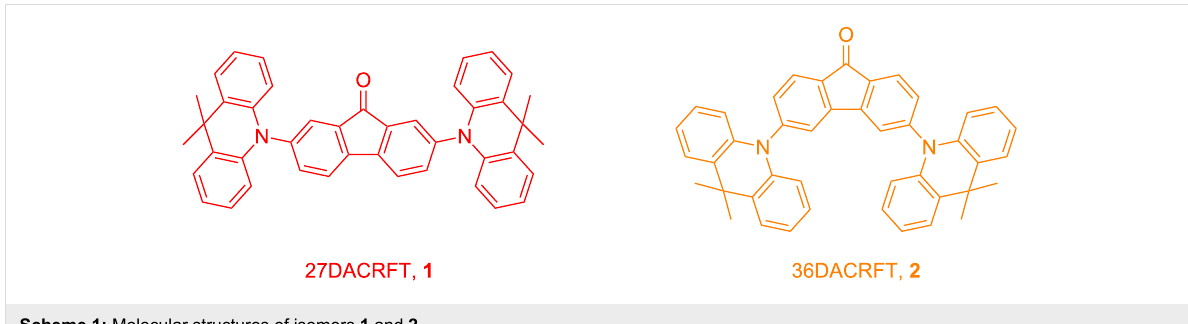
Scheme 1: Molecular structures of isomers 1 and 2